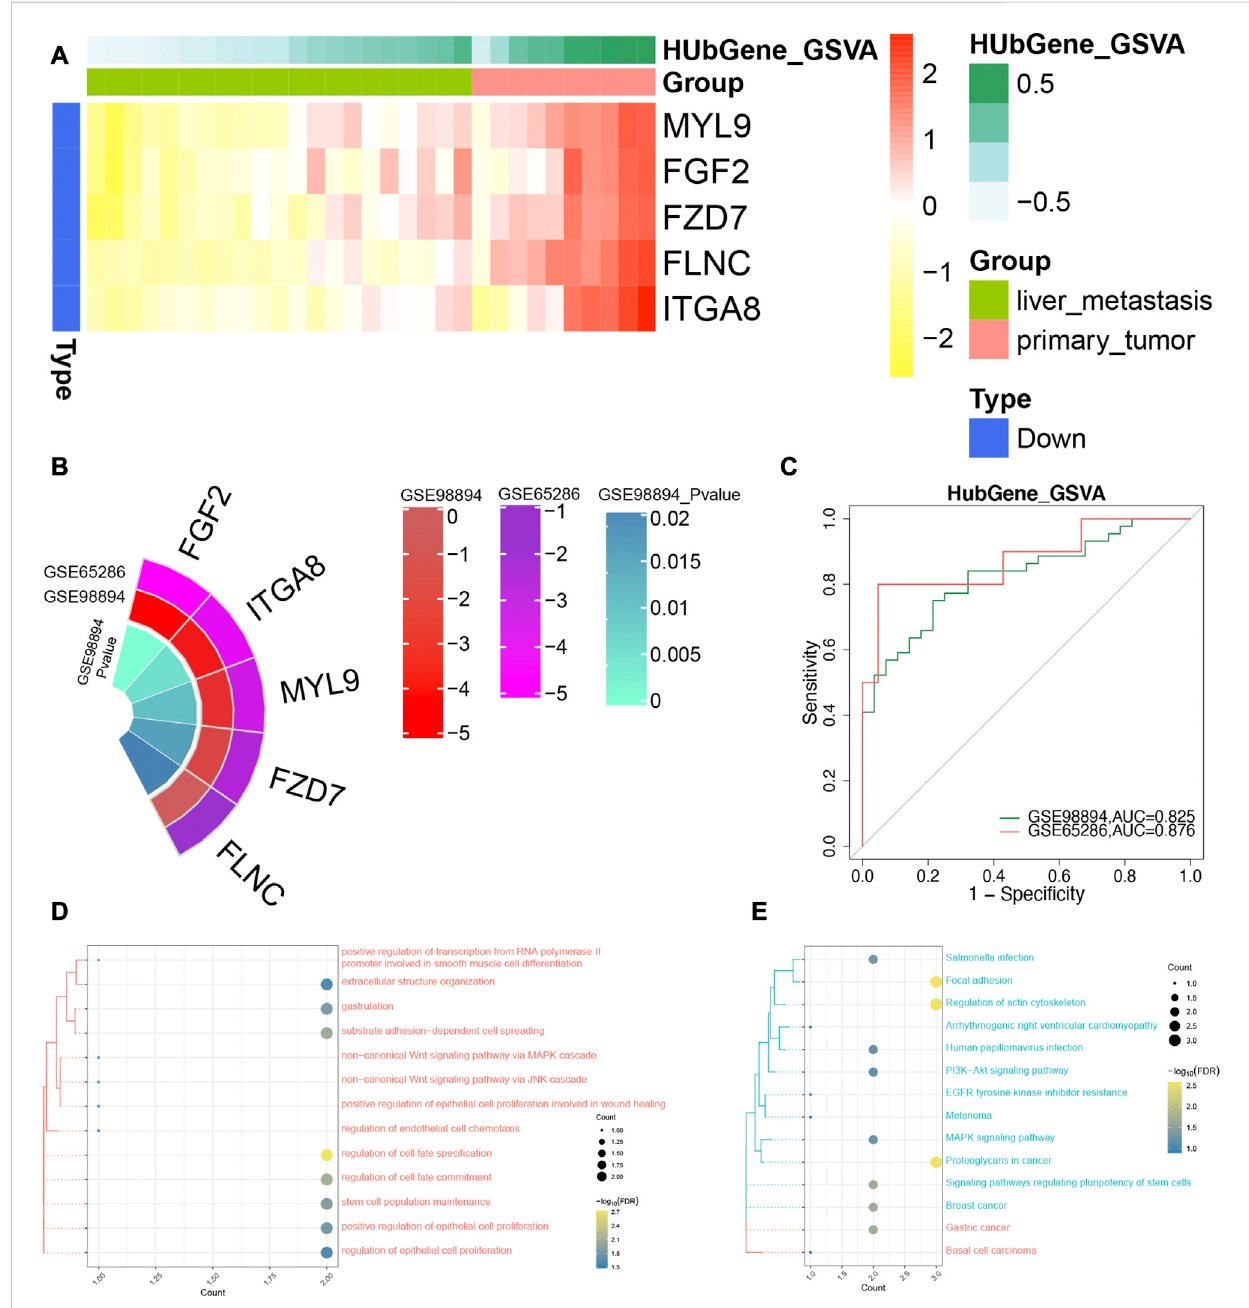
FIGURE 5 The identi fi cation of diagnostic power of the hub genes in SI-NETs. (A) The heatmap for the hub genes in GSE65286. (B) Circo plot: The expression level of the hub genes in GSE65286 and GSE98894. (C) The ROC analysis for the hub genes in GSE65286 and GSE98894. (D) The hub genes are signi fi cantly involved in biological processes. (E) The hub genes are signi fi cantly involved in the KEGG signaling pathway. SI-NETs, small intestine neuroendocrine tumors; ROC, receiver operator